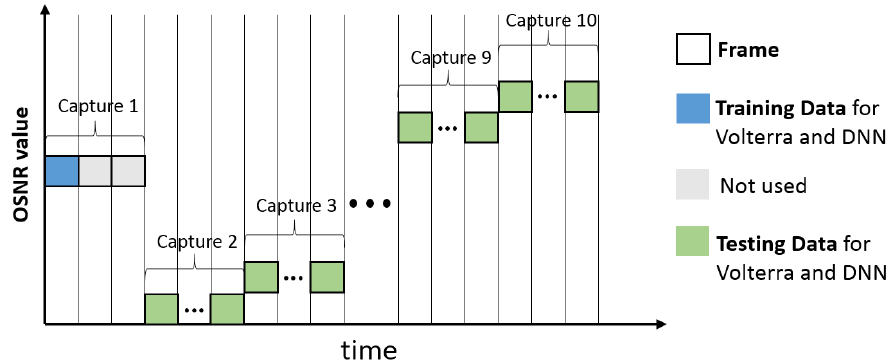
Figure 6. Overview training and evaluation process.